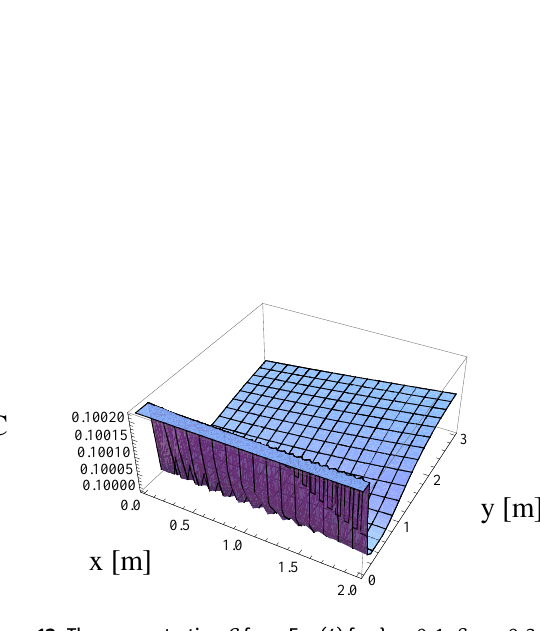
Figure 13: The concentration C from Eq. (4) for λ = 0.1 , S = −0.3 , Sc = 2 , β = 0.1 for hydraulic oil at a temperature of 40 ◦ C